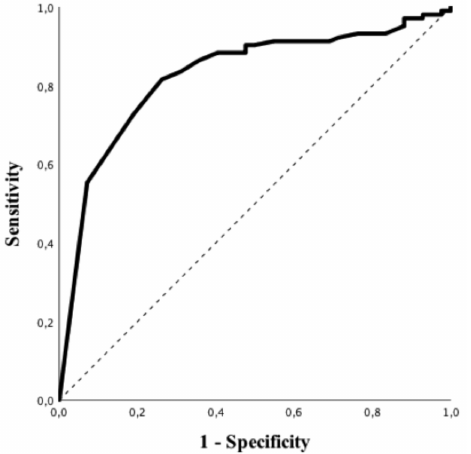
Figure 3. ROC curve of eosinophils counts to predict suggestive CT-scan imaging for